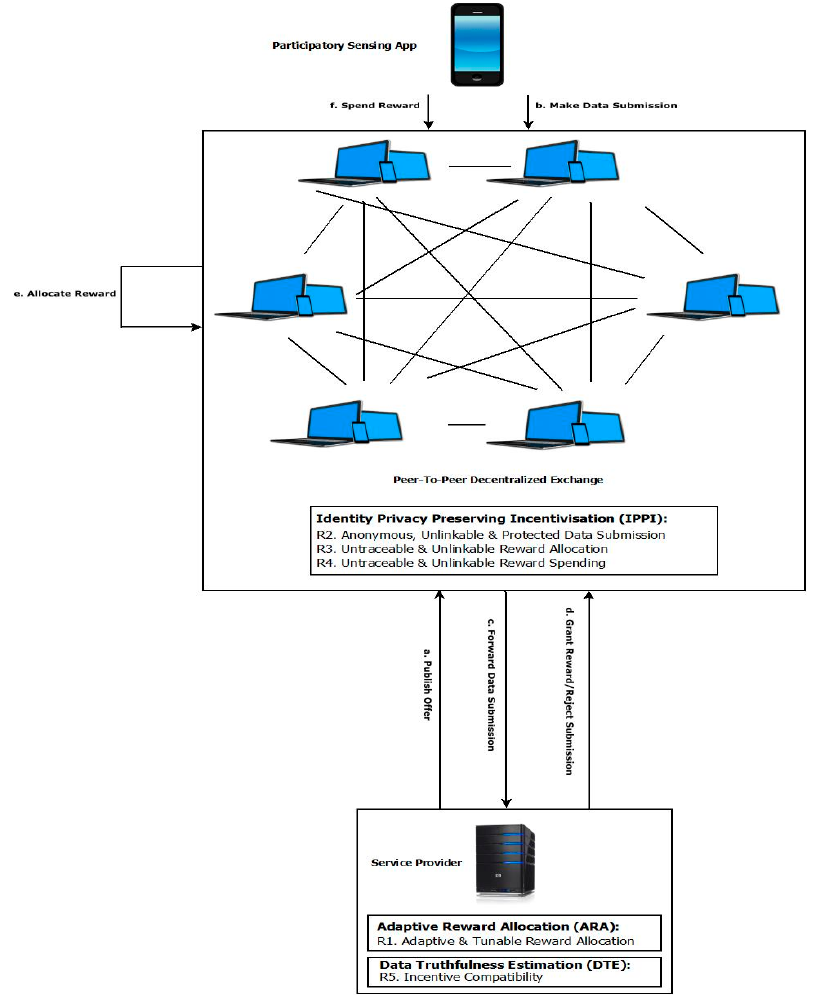
Figure 1. Privacy-Aware Incentivization (PAI) platform.